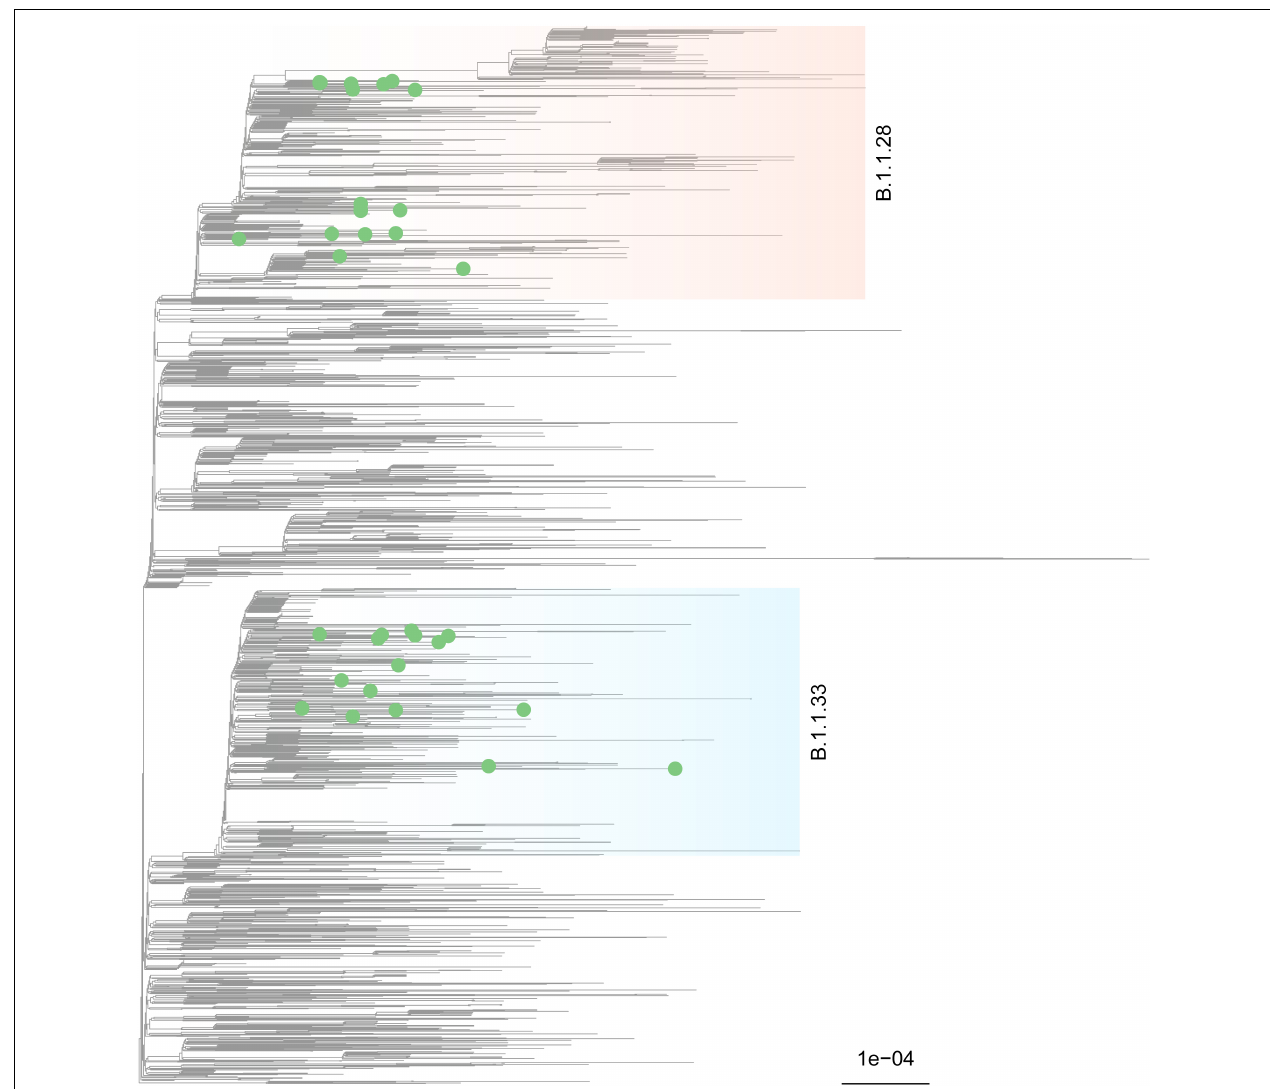
FIGURE 4 | Phylogenetic characterization of SARS-CoV-2 genomes characterized in Betim. A maximum-likelihood tree was inferred on IQ-Tree under the GTR+F+I+G4 model with a comprehensive reference dataset, encompassing all Brazilian sequences plus one international sequence per country per week, from late 2019 to January 12 2021 ( n = 3,814). The phylogeny depicted exhibits a subtree of 2,023 tips that harbors all relevant diversity considered for this study, mainly lineages B.1.1.28 (light salmon) and B.1.1.33 (light blue) where the novel genome sequences sparsely clustered. Tip shapes mark sequences characterized in this study. The scale bar indicates average nucleotide substitutions per